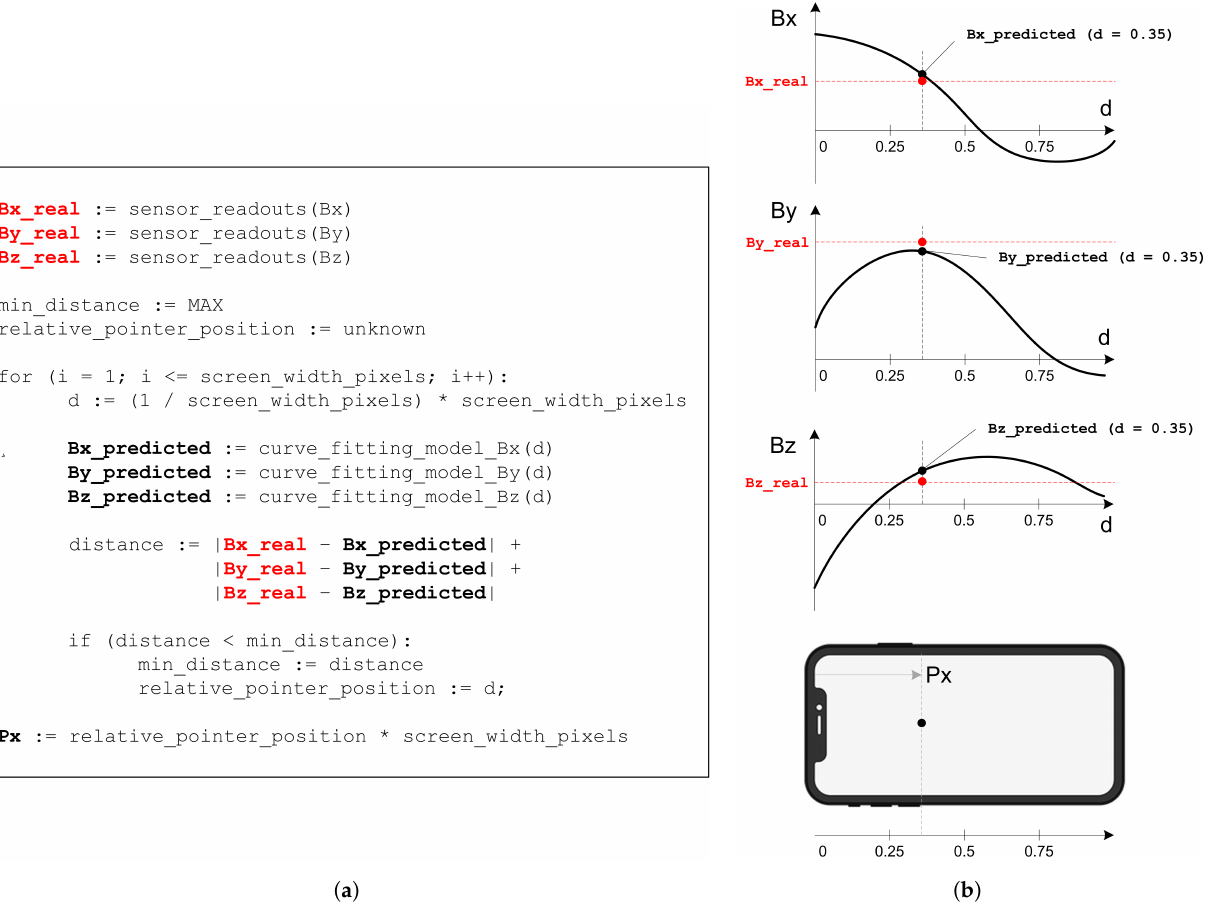
Figure 7. ( a ) Algorithm (pseudo-code) for determining the pointer x-axis location on the smartphone screen, by making use of the curve fitting approach. ( b ) Visualization of the implemented localization